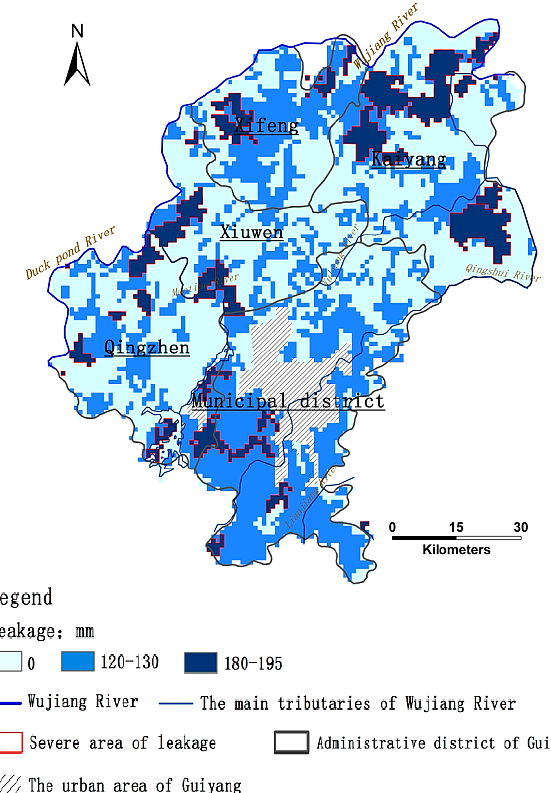
Figure 7. The distribution of leakage in each administrative district of Guiyang in 2013.